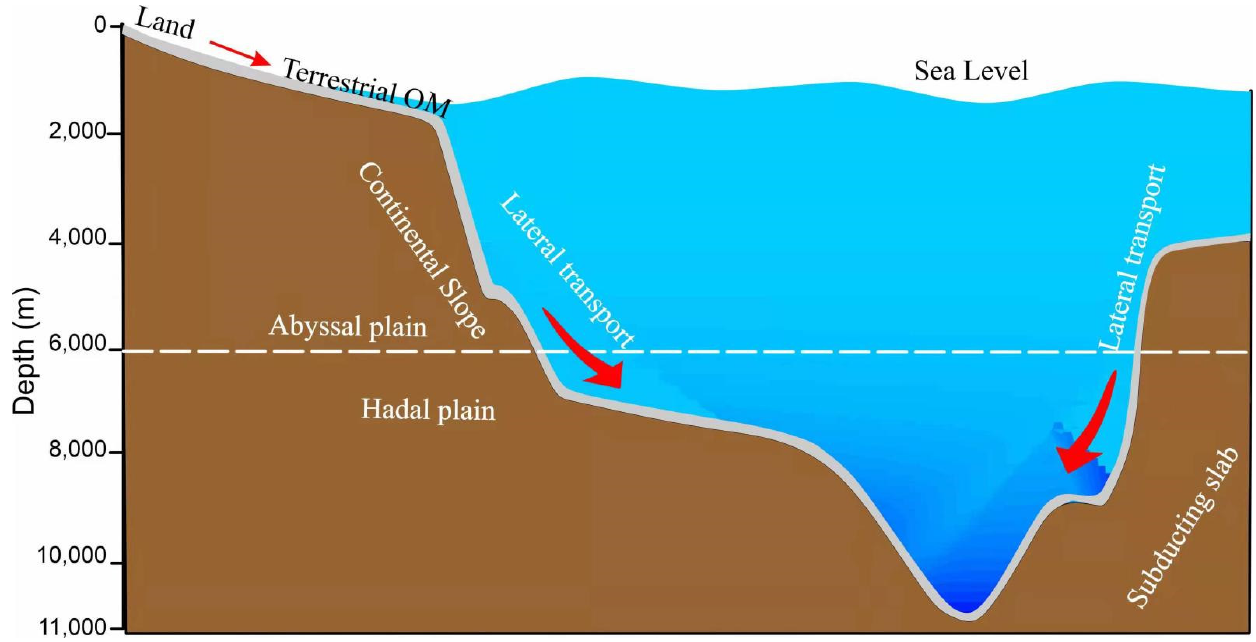
Figure 1. The level of depth, transport, and sources of organic matter in the Yap trench.